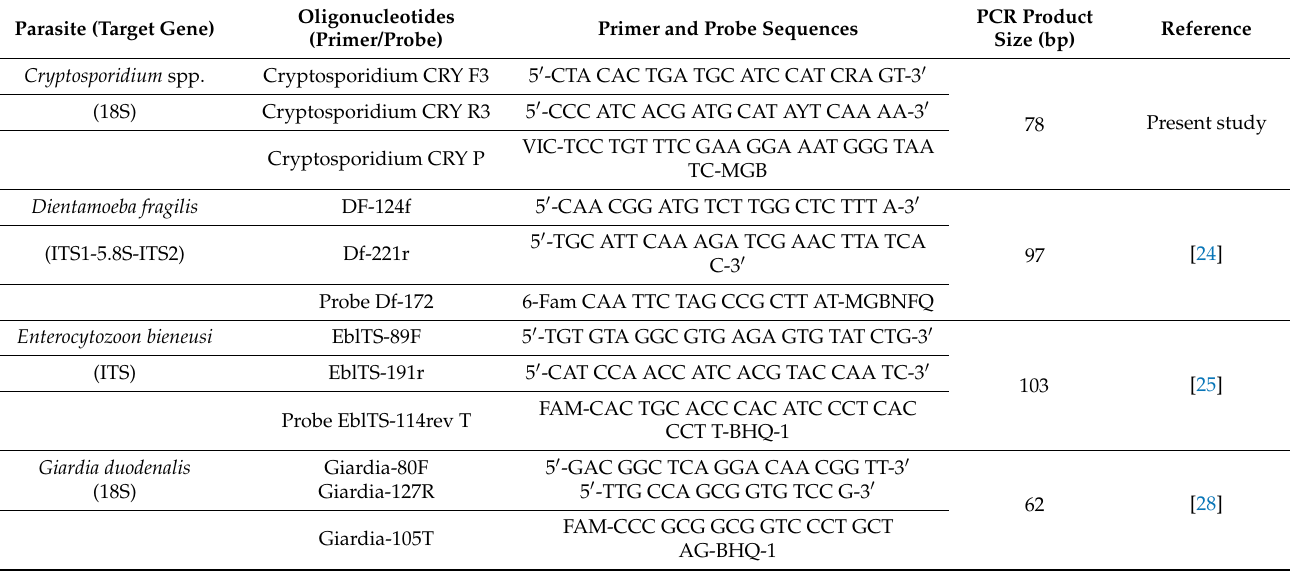
Table 2. Oligos used in the present study for real-time PCR-based detection of selected parasites. Parasite (Target Gene)